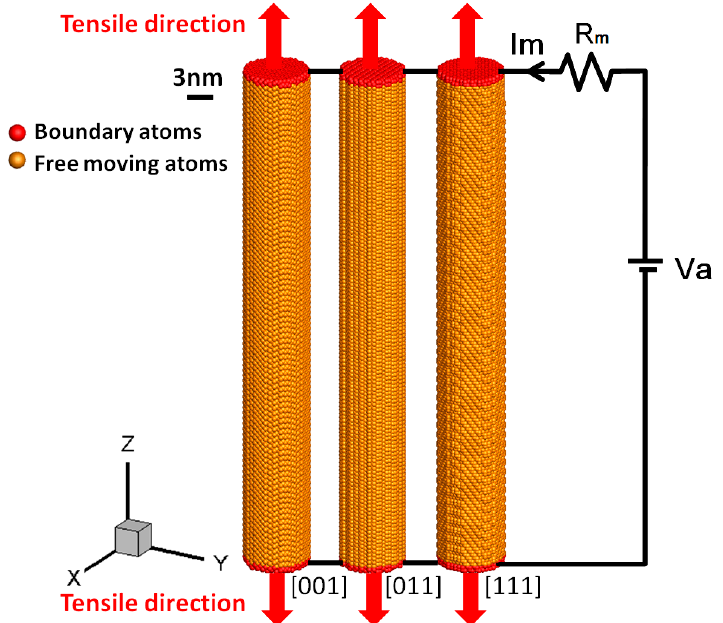
Figure 1. MD Simulation model for the SiNW. A DC voltage is supposed to apply at the top and bottom surfaces from which a circuit is connected.